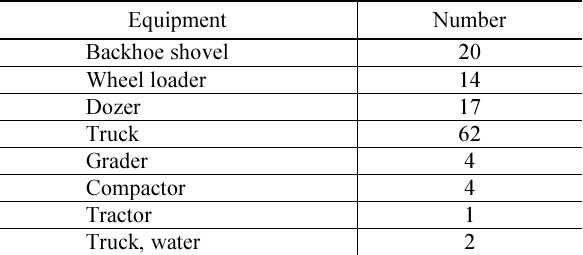
Table 9. Equipment fleet used in the project